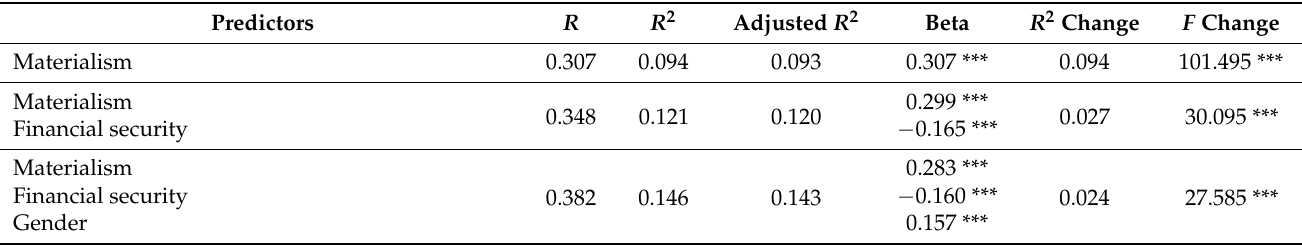
Table A3. Predictors of anxiety